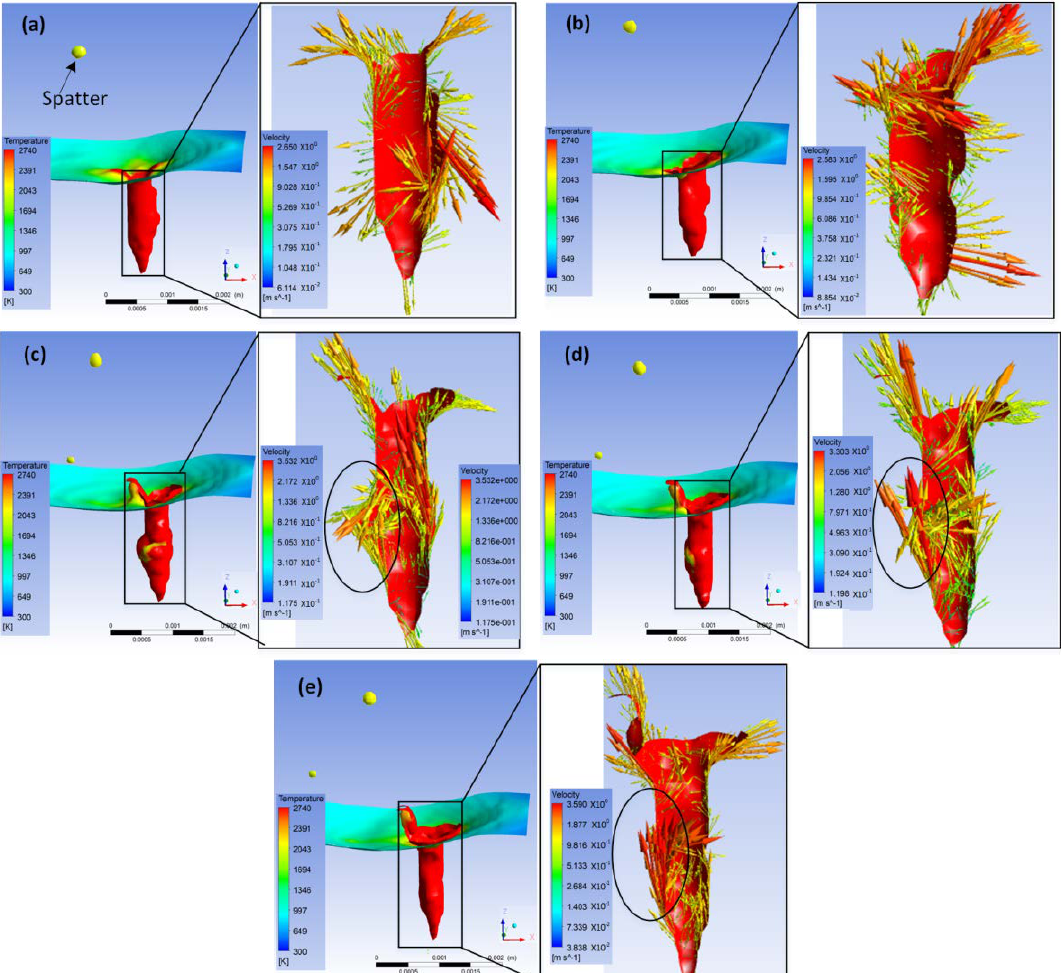
Figure 4. The dynamic fluctuation of keyhole wall and the melt flow on keyhole wall with preheating temperature of 300 K (ambient temperature): ( a ) t = 26.4 ms, ( b ) t = 28 ms, ( c ) t = 29 ms, ( d ) t = 29.1 ms, ( e ) t = 29.2 ms.